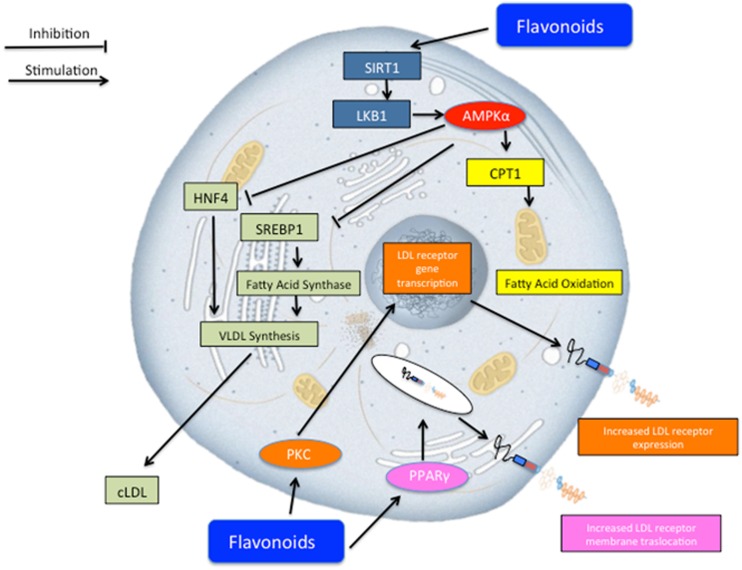
Schematic representation of potential lipid lowering effect of Bergavit® (Bergamot-derived flavonoids: 150 mg of flavonoids, with 16% of neoeriocitrin, 47% of neohesperidin and 37% of naringin, daily). Several mechanisms may concur to regulate lipid homeostasis. Flavonoids may lead to an increase of lipid consumption via activation of mitochondria oxidation and at the same time flavonoids decrease very low-density lipoproteins (VLDL) synthesis. Other potential mechanisms include increased LDL receptor gene transcription via protein kinase C (PKC) activation and increased membrane translocation of this receptor via peroxisome proliferator-activated receptors gamma (PPAR-γ) activation. AMPK-α, adenosine monophosphate-activated protein kinase alpha; CPT1, carnitine palmitoyltransferase 1; HNF4, hepatocyte nuclear factor 4; SREBP-1, sterol regulatory element-binding protein 1.